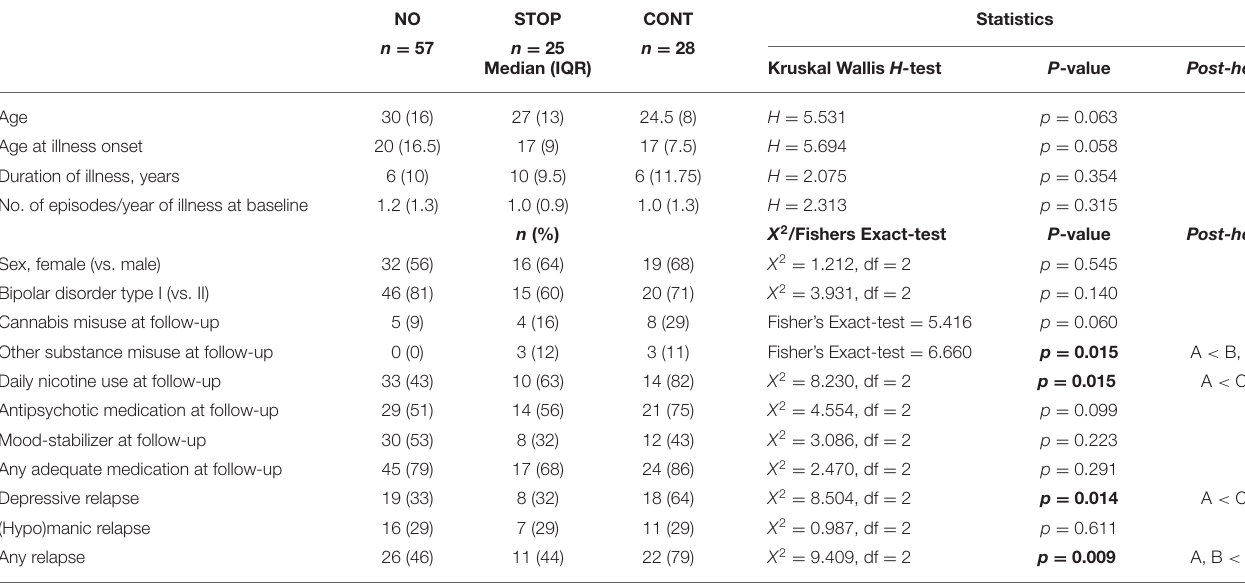
TABLE 4 | Sociodemographic and clinical characteristics across alcohol misuse trajectories.